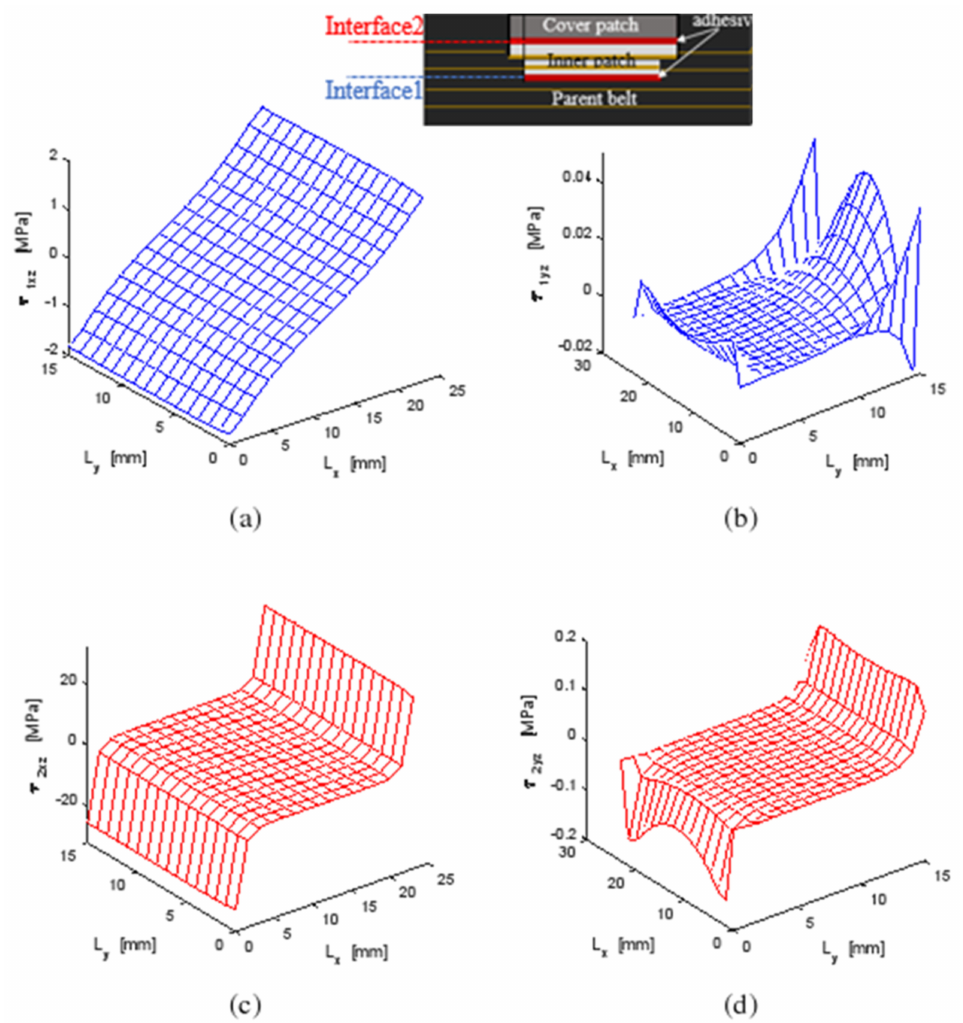
Figure 12. Shear stress distribution under a hygro-thermomechanical load on XZ and YZ planes in ( a , b ) Interface (1); ( c , d ) Interface